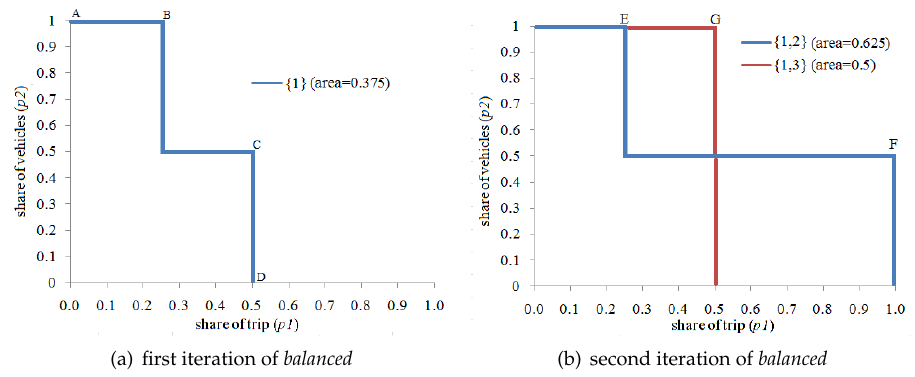
Figure 5. Didactic example on how the balanced strategy operates. ( a ) Presents the Delta Network after covering cell 1 . ( b ) Presents the Delta Network considering two options: (a) Covering cell 2 ; (b) covering cell 3 . Since covering cell 2 leads to a major area under the curve, cell 2 is